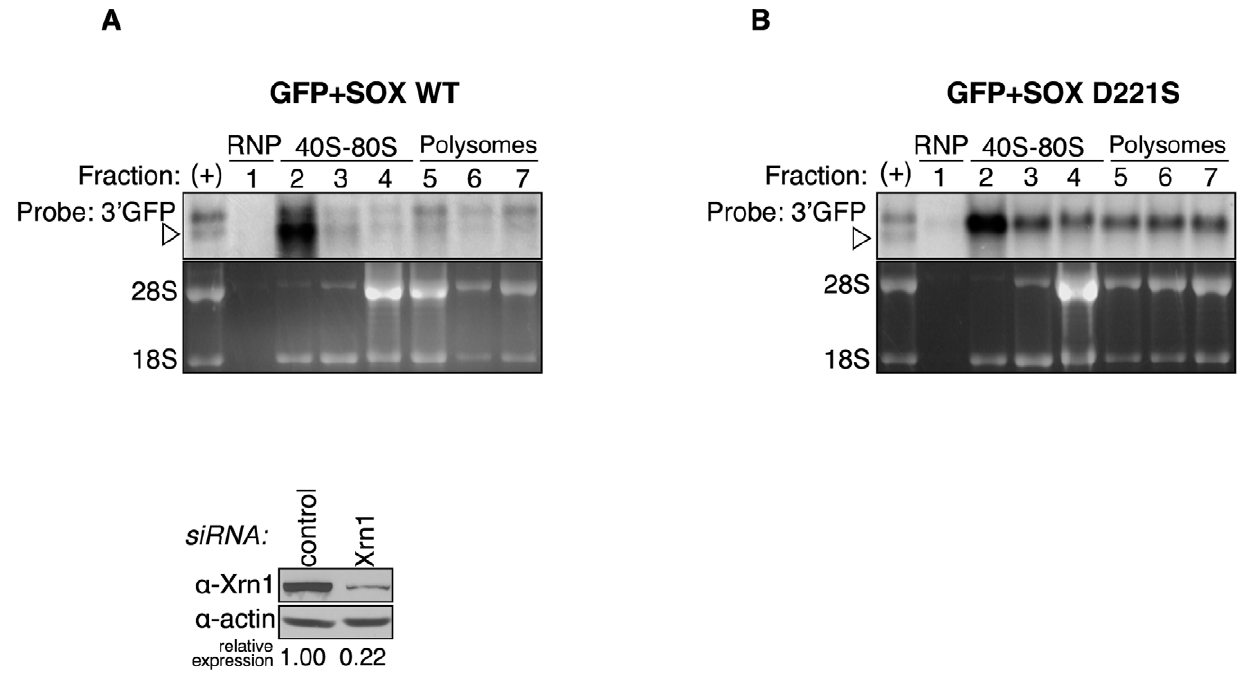
Figure 7. The degradation intermediate sediments predominantly with the 40S fractions. 293T cells were transfected with Xrn1 shRNA, followed by expression of GFP and either wild-type (WT) SOX (A) or the catalytically dead SOX D221S (B). They were then fractionated over sucrose gradients and RNA from each fraction was Northern blotted with a 3 9 GFP probe. Ribosomal RNA was visualized by ethidium bromide staining. In both panels the ( + ) lane shows the migration of full-length GFP and the degradation intermediate in unfractionated RNA from cells expressing wild- type SOX. It was used as a reference to identify the different RNA species in the fractionated RNA. Arrowheads point to degradation intermediates.